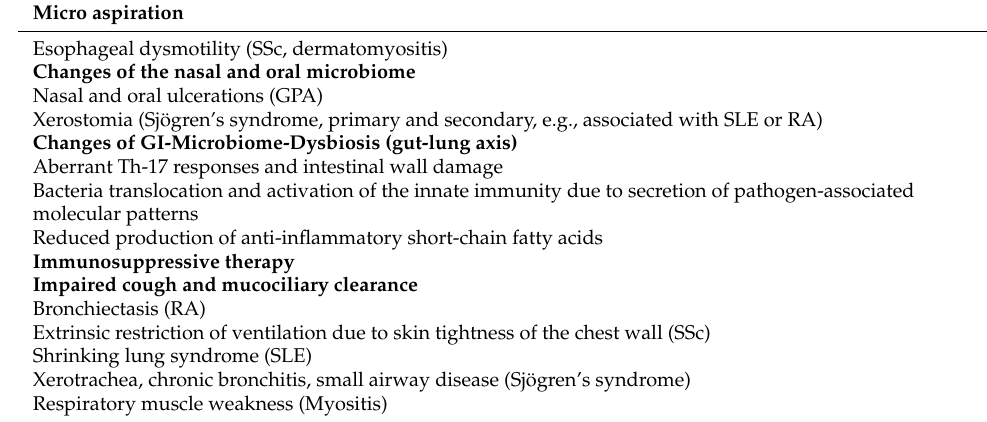
Table 1. Putative factors affecting the lung microbiome in CTD-ILDs and pulmonary vasculitis. Micro